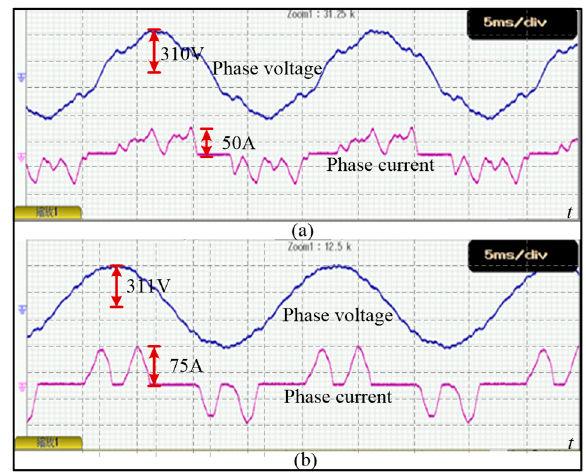
Figure 17. Voltage and current waveforms with non-linear load. ( a ) Without resonant controller; ( b ) With resonant controller.